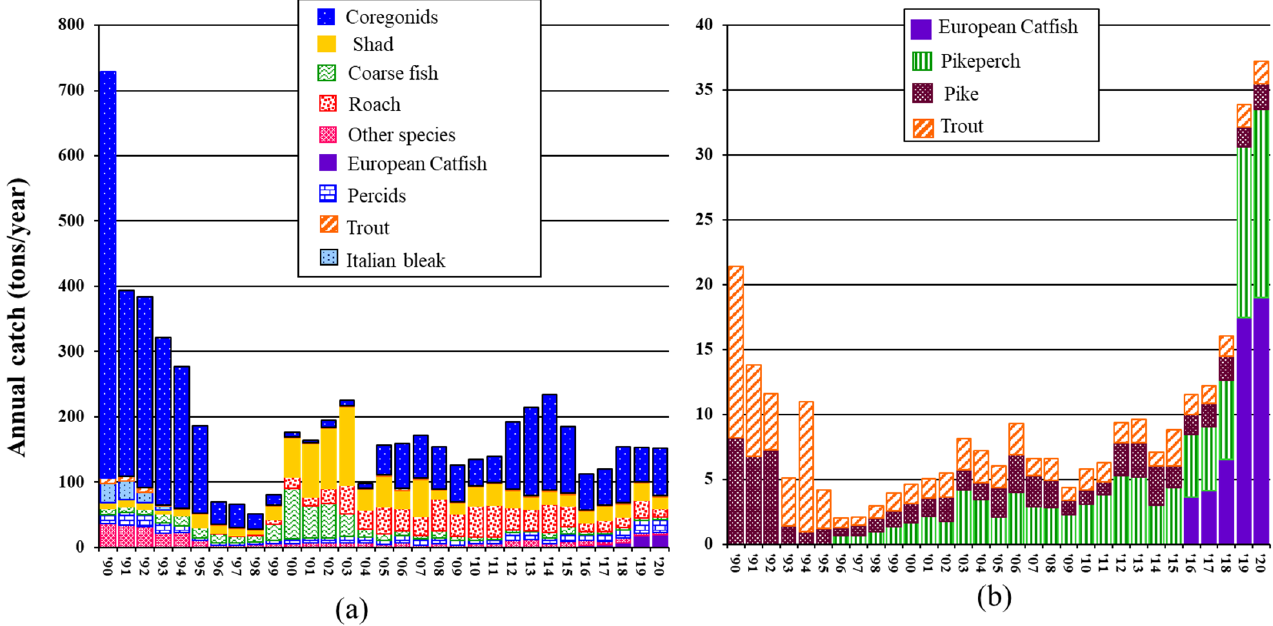
Figure 6. Species-specific ( a ) and predators-only ( b ) fish harvest composition (tons/year) in L. Maggiore since the invasion of S. glanis (1990–2020), where Coregonids = “lavarello” and “bondella” Coregonus sp.; Percids = S. lucioperca , P. fluviatilis and G. cernua ; Trout = Salmo spp.; Italian bleak = Alburnus alborella (Bonaparte, 1841); other species = S. umbla , L. lota , E. cisalpinus , Anguilla anguilla (L.), Tinca tinca (L.) and Cyprinus carpio L.